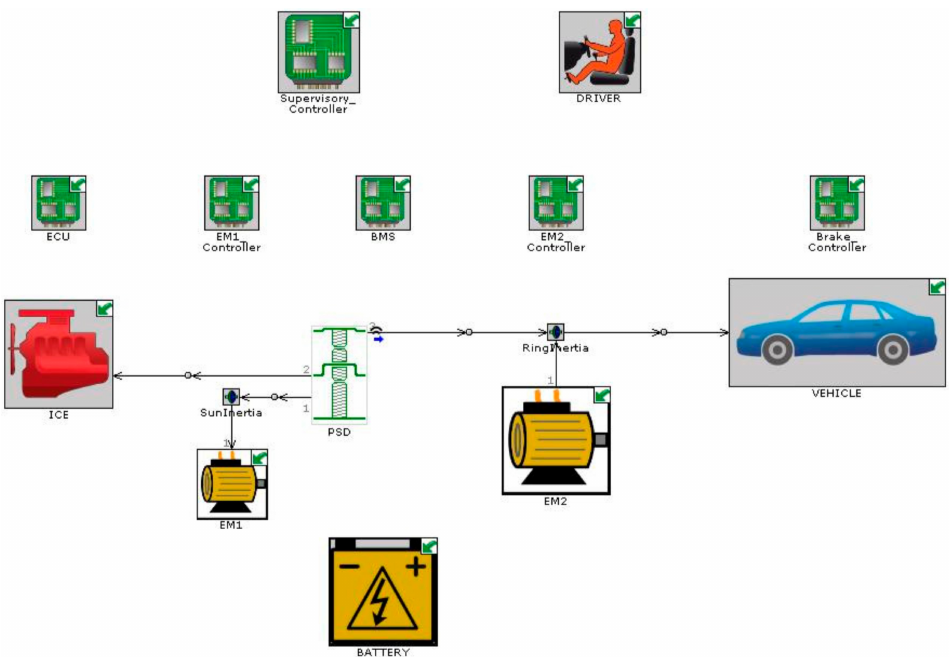
Figure 16. Power Split Hybrid Electric Vehicles (HEV) Model in